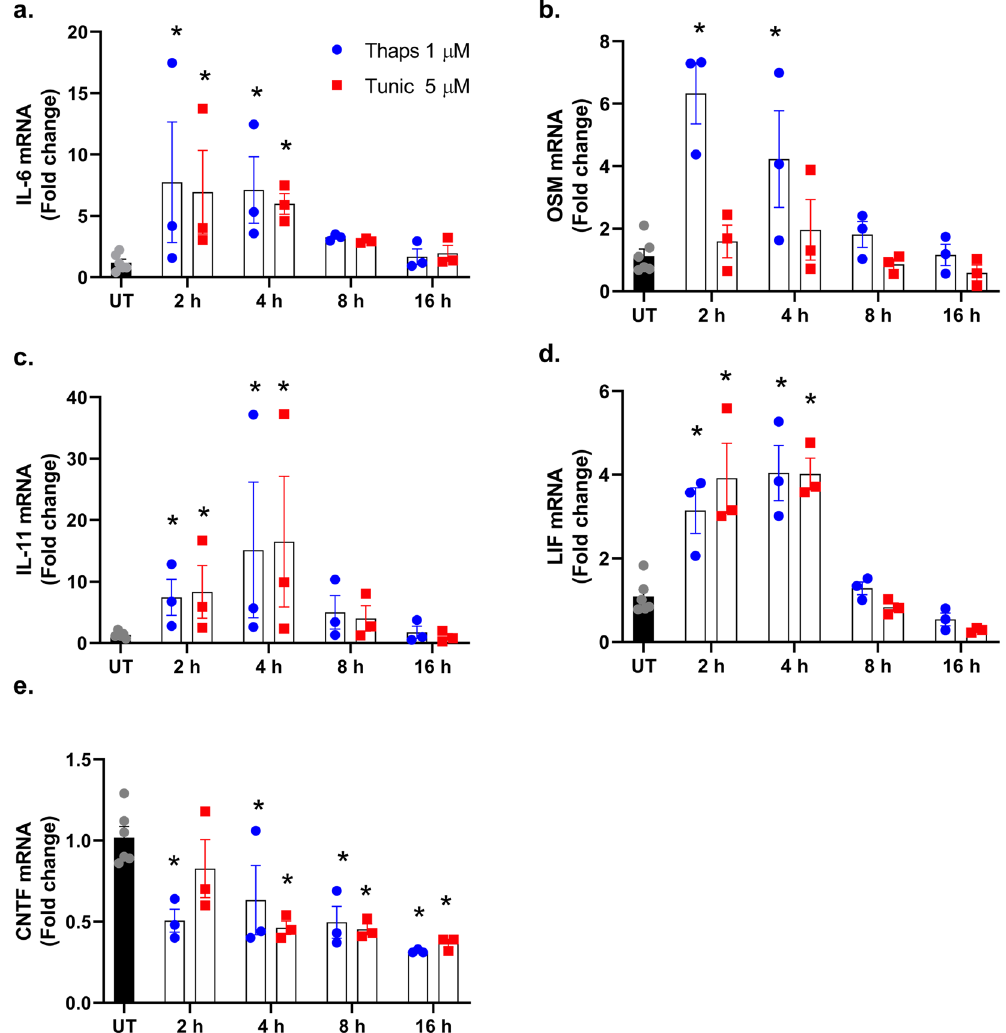
Figure 1. Time-course of the IL-6 cytokine family expression in astrocytes during ER stress. ( a – e ) Wild type primary murine astrocytes were stimulated with 1 µ M thapsigargin (thaps) or 5 µ M tunicamycin (tunic), and mRNA expression was analyzed by qPCR at the indicated time points. Untreated (UT). N = 3, * P ≤